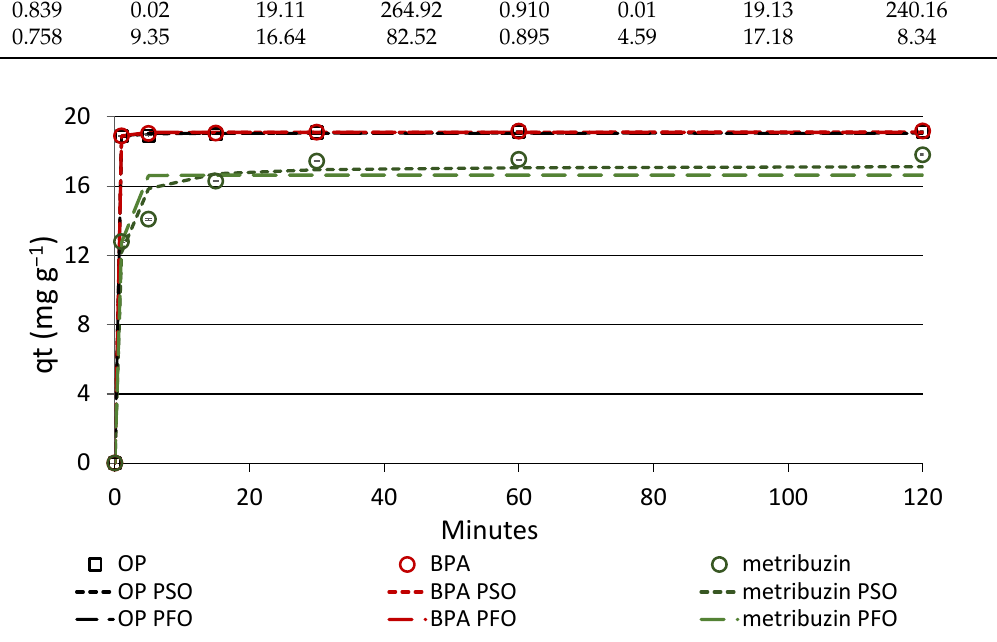
Figure 5. Adsorption kinetics data and plots of predicted PFO and PSO kinetics of the compounds onto biochar. Standard error is reported as vertical bar on each point (n = 3).